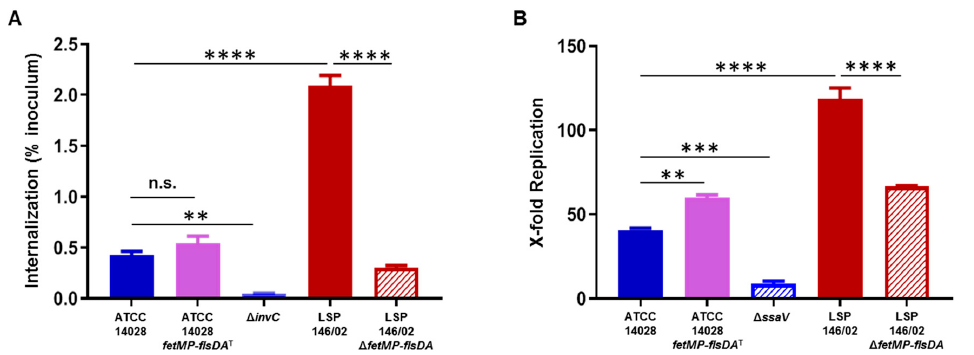
Figure 7. Invasion of epithelial HeLa cells by S. Typhimurium ATCC 14028 harboring the cloned fetMP - flsDA genes (ATCC 14028 fetMP - flsDA T ) ( A ) and replication of the same strain within RAW264.7 macrophages ( B ). The data are the mean values ± standard deviations of three biological replicates. Statistical significance (**** p < 0.0001; *** p < 0.001; ** p < 0.01) was determined by one-way ANOVA and the Tukey´s post-test.